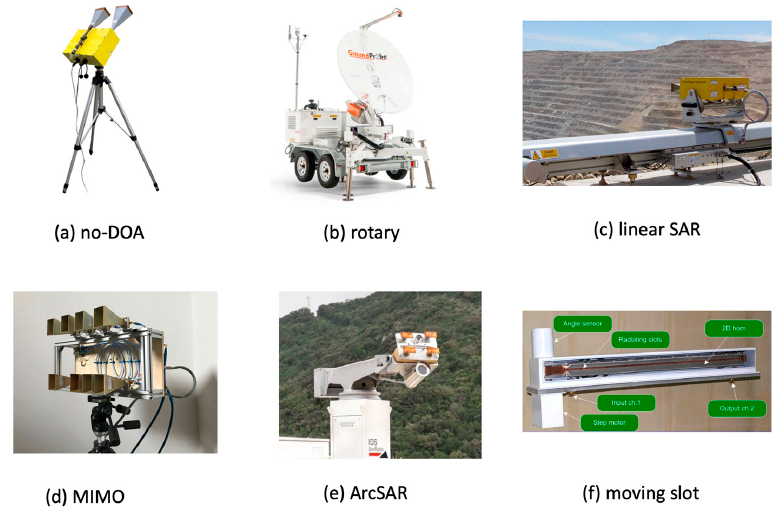
Figure 4. Examples of ground-based radar interferometers: ( a ) no-DOA (after [48]); ( b ) Rotary (after [49]); ( c ) linear SAR (after [48]); ( d ) MIMO (after [50]); ( e ) ArcSAR (after [48]); ( f ) moving slot (after